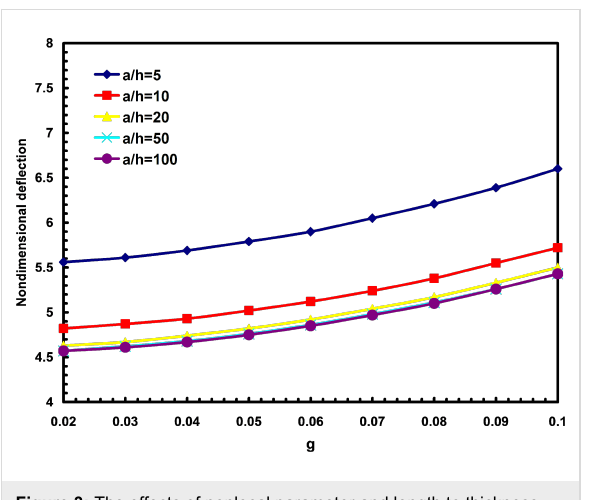
Figure 3: The effects of nonlocal parameter and length to thickness ratio on the nondimensional deflection.